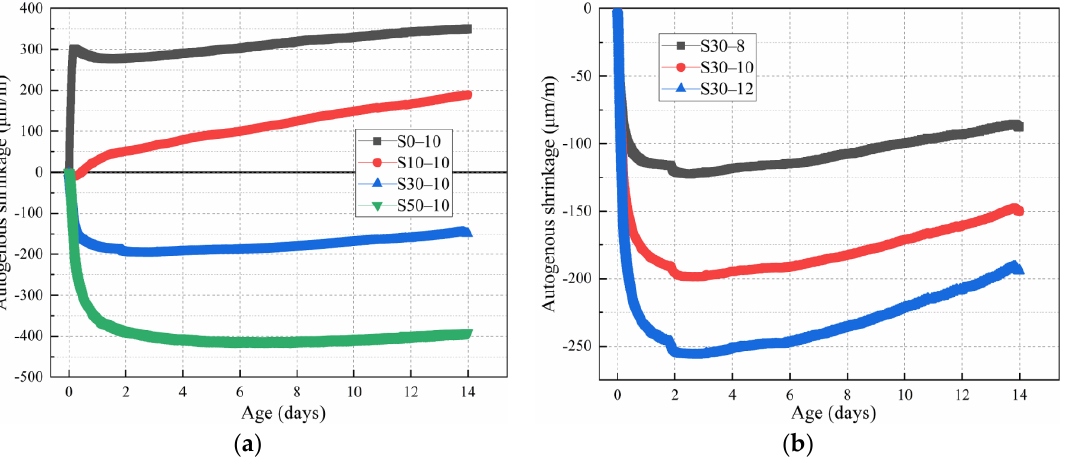
Figure 5. Autogenous shrinkage of the alkali-activated metakaolin-based geopolymer specimens according to the ( a ) slag and ( b ) Na 2 O content.